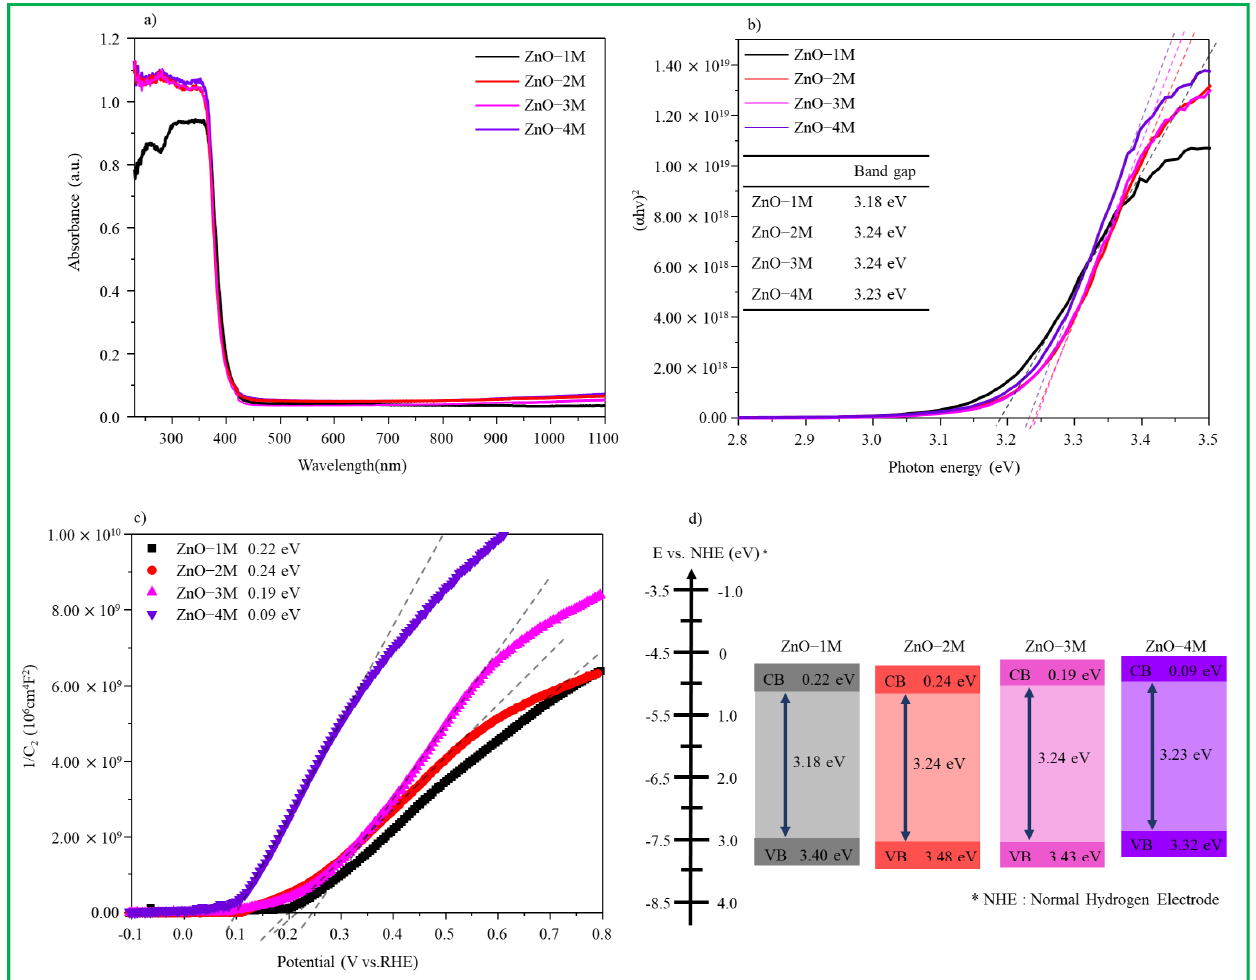
Figure 3. ( a ) DRS-UV-Visible absorption spectra, ( b ) Tauc’s plot curves, ( c ) Mott–Schottky’s plot curves, and ( d ) energy diagrams for the bandgap positions of the